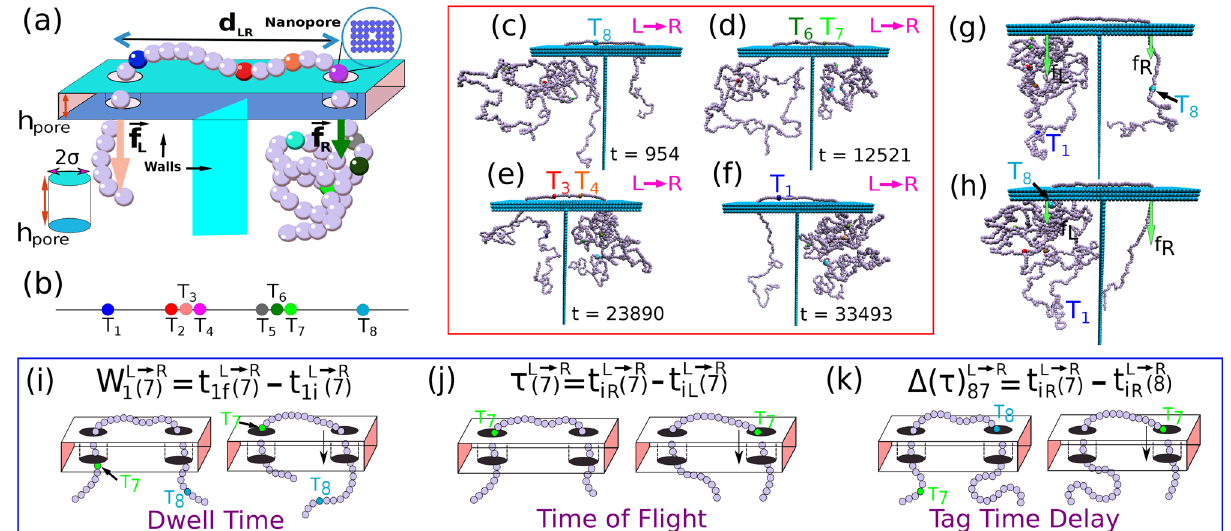
Figure 1. ( a ) Schematic diagram of a dsDNA captured in between two nanopores drilled through an infinitely extended material with thickness h pore and at a separation distance d LR . External bias forces (cid:31) f L and (cid:31) f R are applied to the monomers in the left and right nanopore respectively. The colored beads are tags attached to the nucleotides and have different mass and solvent friction different from the rest of the monomers. Keeping the tug of war force at a fixed value, the force (cid:31) f L and (cid:31) f R are applied and varied so that DNA in between the pore has a bias (cid:31) � f LR = � f L − � f R to floss it from one pore to the other. ( b ) Positions of the protein tags along the dsDNA. Figures ( c )–( f ) show the translocation of the tags from L → R direction during scanning. The progressive uncoiling of the dsDNA contour length at the cis side and recoiling at the trans side due to the tension propagation (as observed from the simulation trajectories and the movies) are important elements to be considered to calculate the barcodes accurately (Supplementary Fig. S2). ( g ) Demonstration of flossing the DNA keeping it captured in the double nanopore system. The configuration shows a translocation taking place from R → L direction so that � (cid:31) f LR > 0 and the last tag is on the right chamber. ( h ) Shows a snapshot a while later when the last tag has completed the translocation through both the pores, at which point the differential voltage is reversed so that � (cid:31) f RL > 0 and the translocation proceeds in the L → R direction. ( i ) Dwell time of T 7 is calculated by recording the time difference between arrival t L → R 7 ) and exiting time t L → R ( 7 ) within the 1 i ( 1 f left nanopore thickness for L → R translocation (see Eq. 1). ( j ) Illustration depicts the time of flight ( tof ) of T 7 is measured as the time taken to reach to right pore from left pore for L → R motion. ( k ) Demonstration of calculation of tag time delay �(τ) L → R 87 = t L → R iR ( 7 ) − t L → R iR ( 8 ) for tags T 7 and T 8 at the right pore. The similar quantity for R → L translocation �(τ) R → L 78 = t R → L iL ( 8 ) − t R → L iL ( 7 ) �= �(τ) L → R 87 as of the asymmetric tag positions along the chain. Figure ( c )–( h ) are generated using VMD 26 . Please also refer to the movie in the Supplemantary